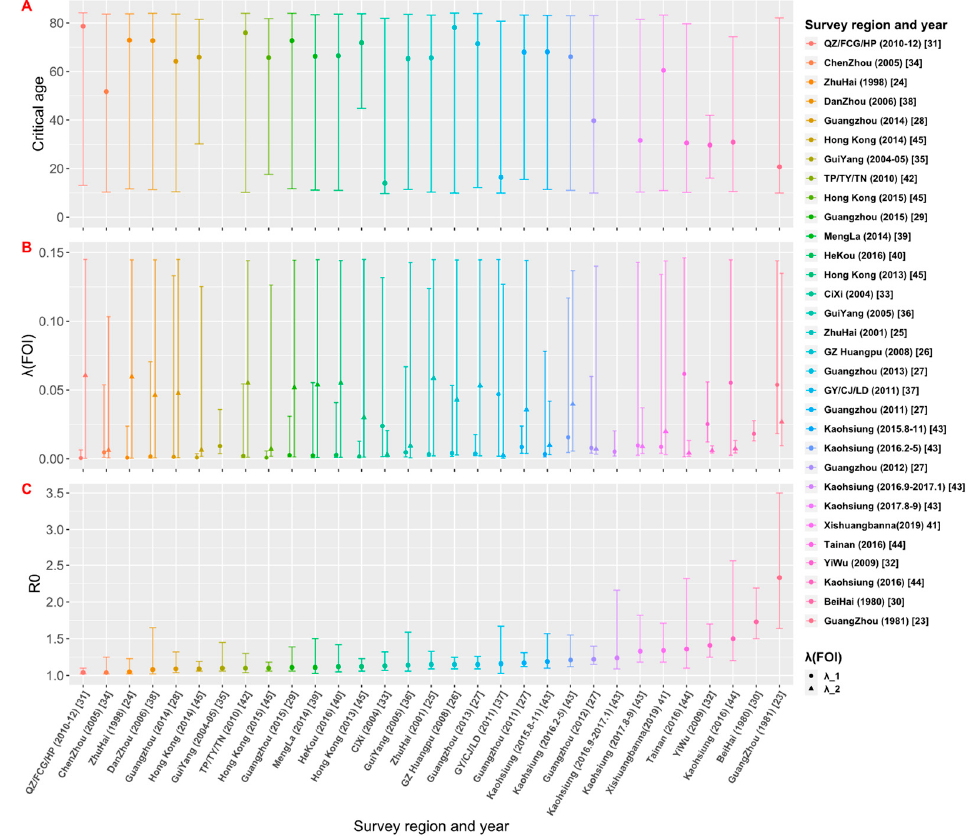
Figure 5. Estimates of ( A ) critical age (A crit ), ( B ) force of infection (FOI), and ( C ) basic reproduction number (R 0 ) based on the best model fittings to data sets. The estimates from 31 data sets are number( R 0 )basedon thebest modelfittings todata sets. Theestimates from31 datasets arearranged arranged in the ascending order of R 0 . in the ascending order of R 0